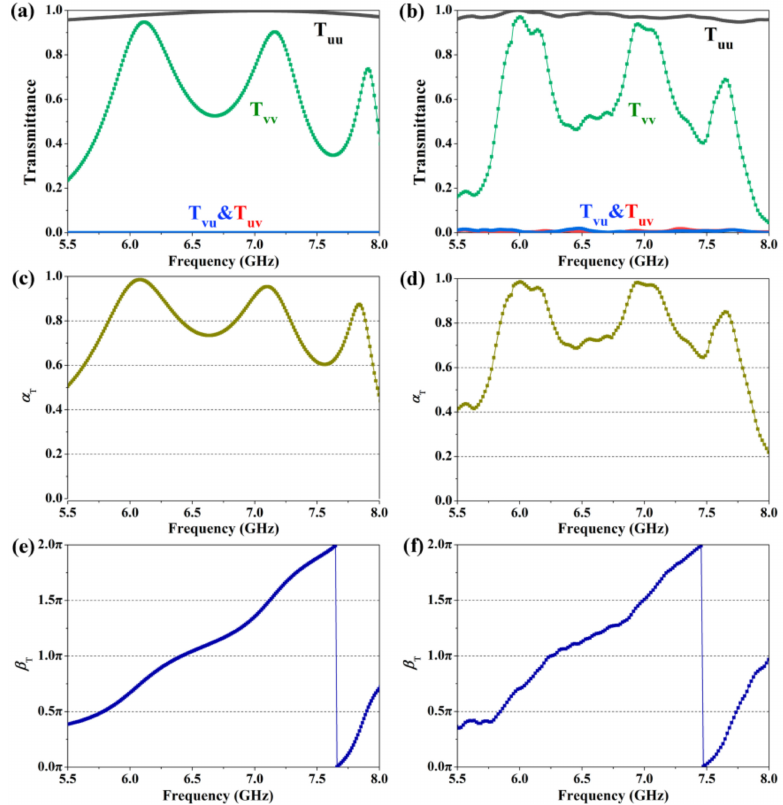
Figure 2. Simulation (left column) and experimental (right column) results of the proposed metagrating in the case of u - and v -polarization incidence. In this frequency region, the metamaterial operates in transmission mode. ( a , b ) Transmittance, ( c , d ) calculated amplitude ratio α T , ( e , f ) phase difference β T between u - and v